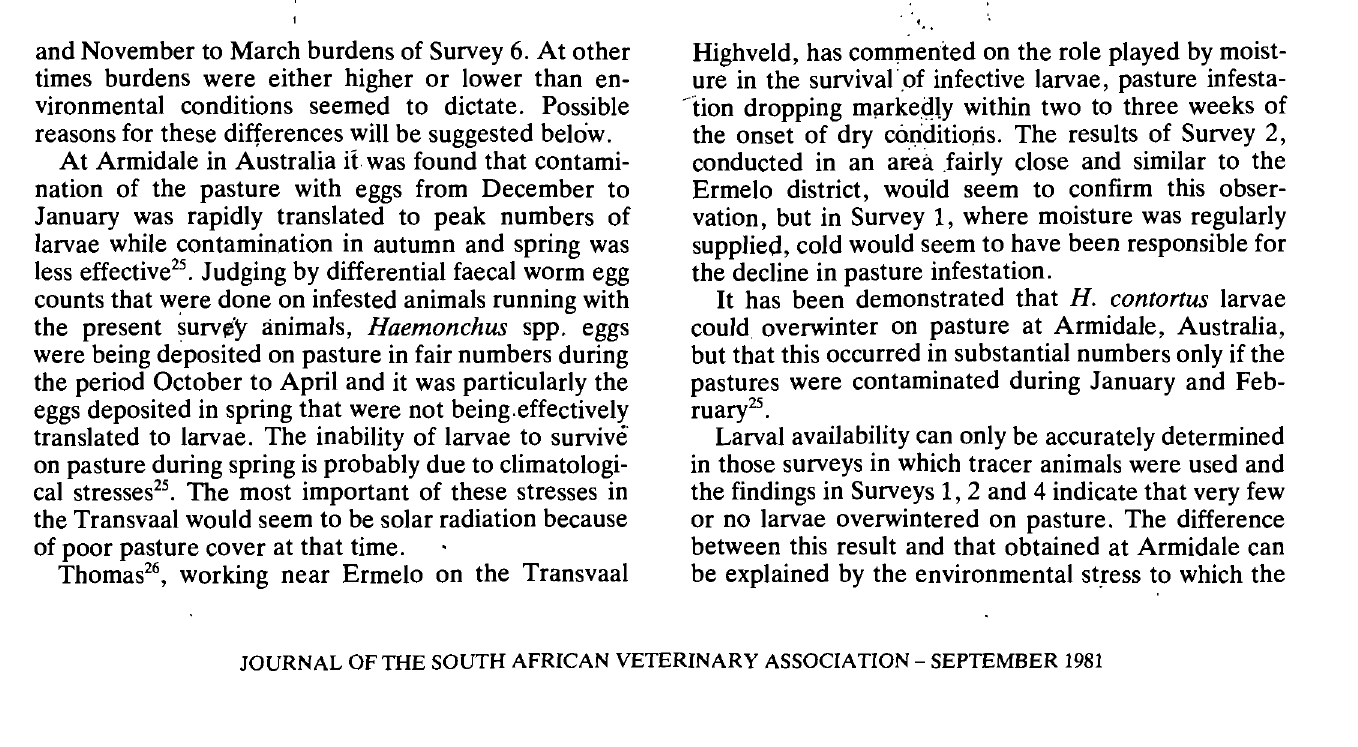
Fig. 2 The seasonal incidence of Haemonchus spp. in sheep, cattle, impala and blesbok slaughtered in surveys conducted in the Transvaal. Surveys 1 and 2 - sh~ep, Surveys 3 and 4 - cattle, Survey 5 - impala, Survey 6 - blesbok··